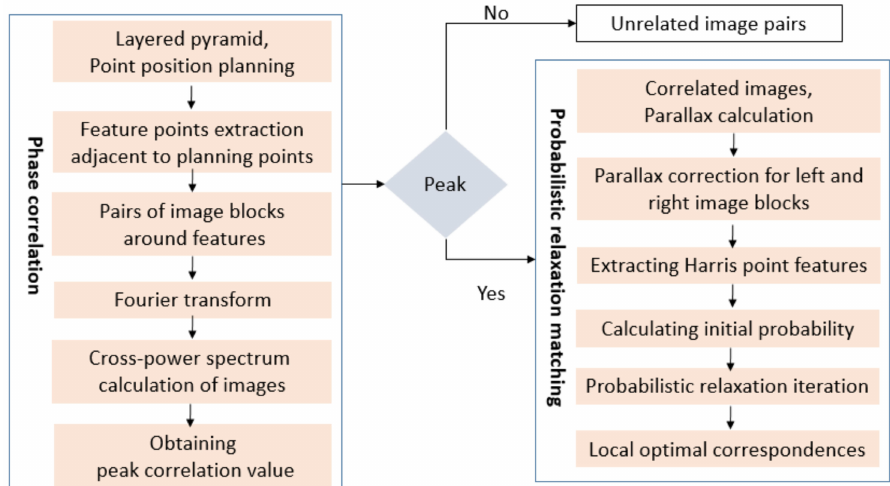
Figure 5. PPFPR matching